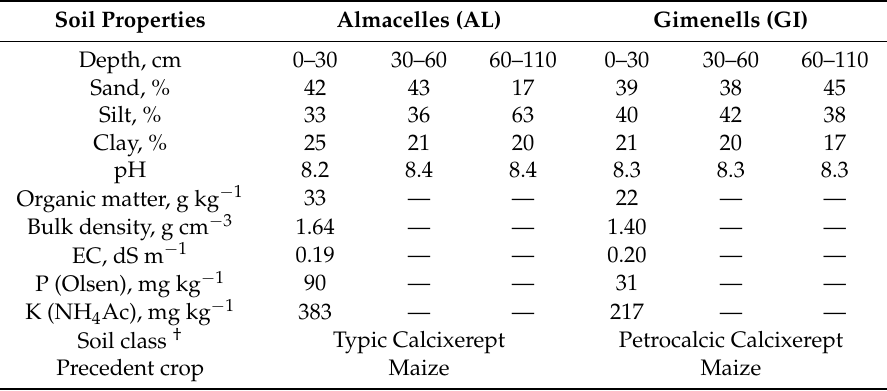
Table 1. Chemical and physical soil properties of the experimental fields (2014). Soil Properties Almacelles